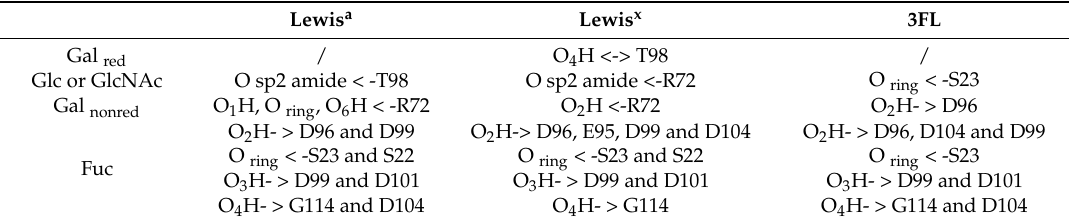
Summary of the interaction of Lewis a tetrasaccharide, Lewis x tetrasaccharide and 3-Fucosyllactose (3FL) with LecB. Red. and nonred. stand for reductive and nonreductive ends. (all amino acids belong to monomer B except G114 (monomer